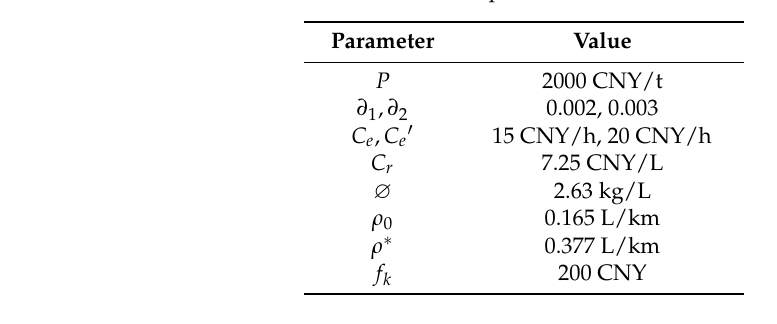
Table 5. Relevant parameters of the